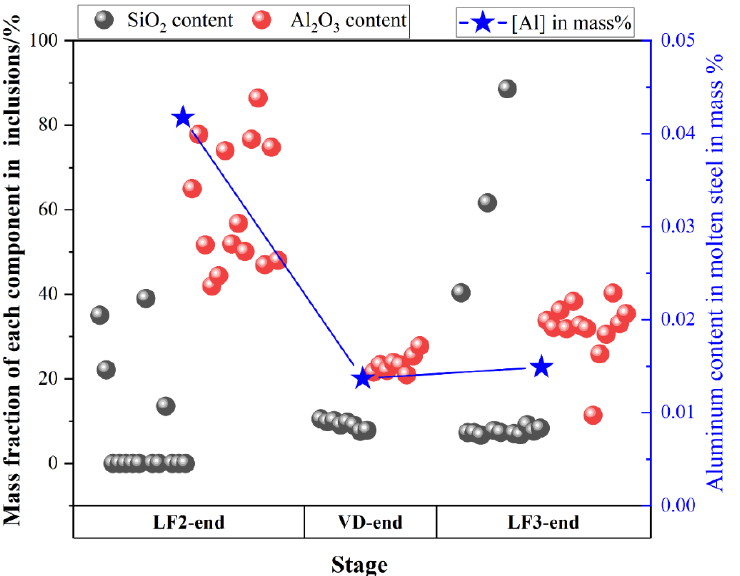
Figure 11. Mass fraction of SiO 2 and Al 2 O 3 contents in the inclusions and the corresponding aluminum content during LF2-end, VD-end, LF3-end stage.